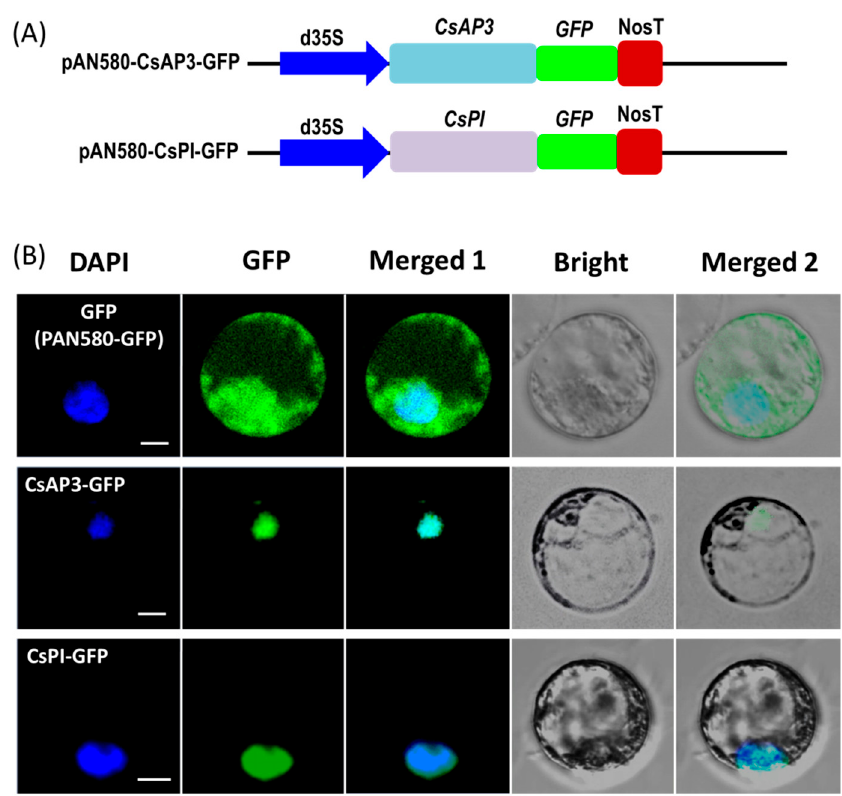
Figure 3. Protein subcellular localization studies using the PTES. ( A ) Vectors used for transient expression were obtained by cloning the full-length coding sequences (CDSs) of CsAP3 and CsPI into the vector PAN580-GFP. ( B ) Recombinant vectors pAN580- CsAP3 - GFP and pAN580- CsPI - GFP , as well as empty control vector (expressing GFP) were transformed into Cymbidium protoplasts to test feasibility of the PTES for protein subcellular localization; fusion proteins CsAP3-GFP and CsPI-GFP were both colocalized with the DAPI signal, indicating nuclear localization of both fusion proteins; bar = 10 μ m.